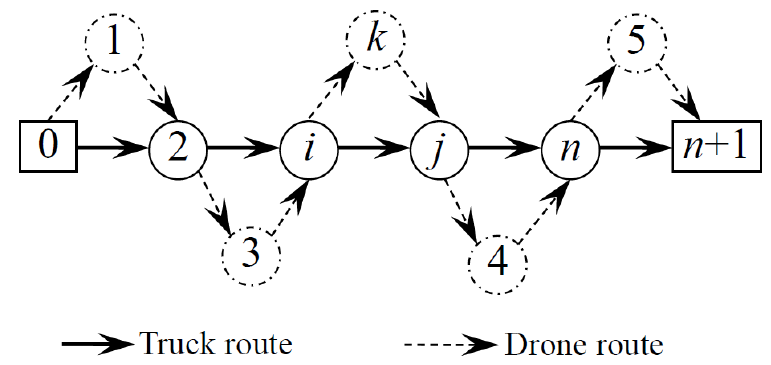
Figure 1. Truck–drone delivery routes.